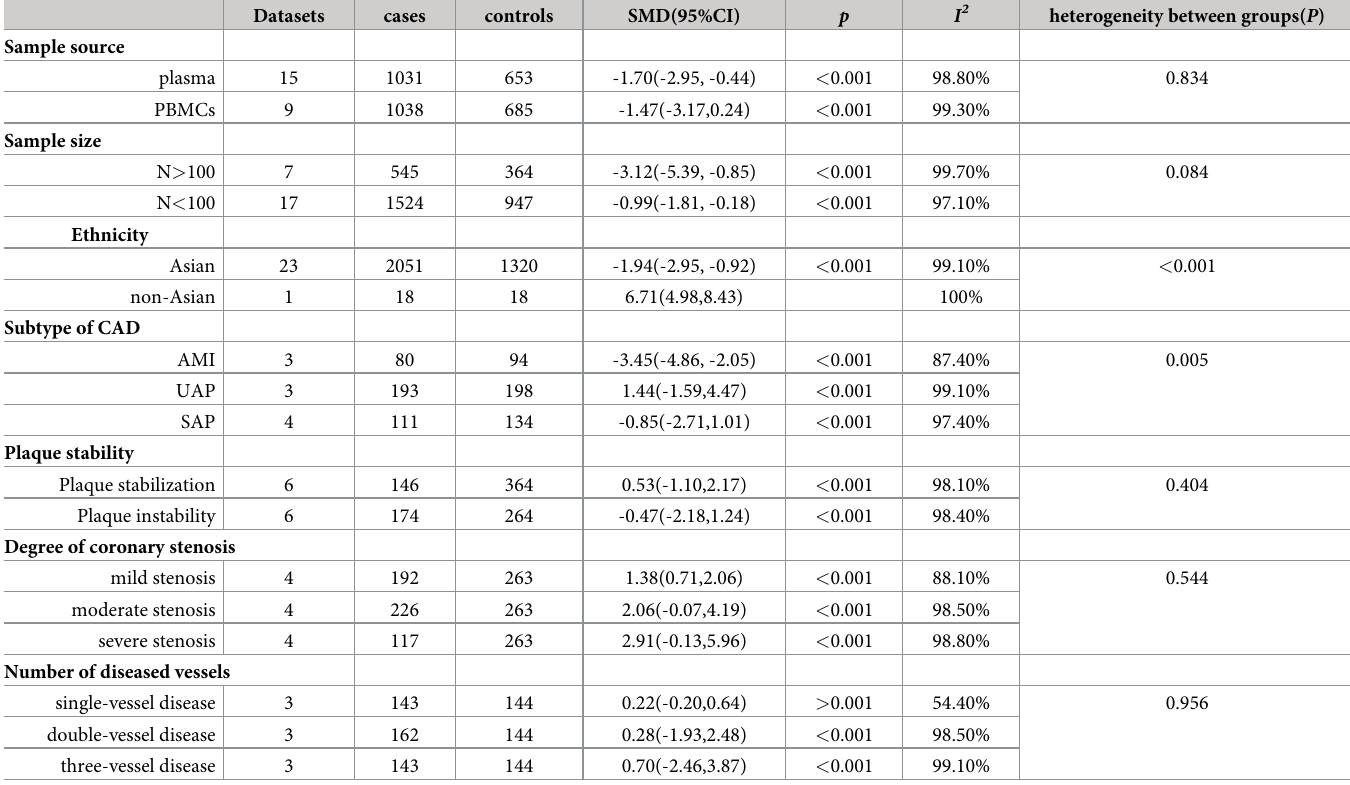
Table 2. Results of subgroup